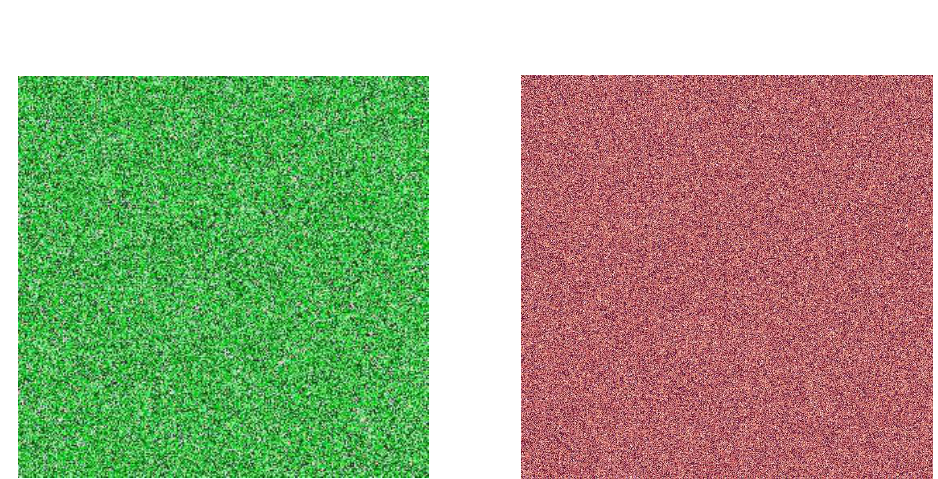
Figure 4. The cipher fractal image (left) and non-fractal image (right) from Figure 1 after using the 2D mKdV linear map in Eq. (29) for 130 r  iterations.